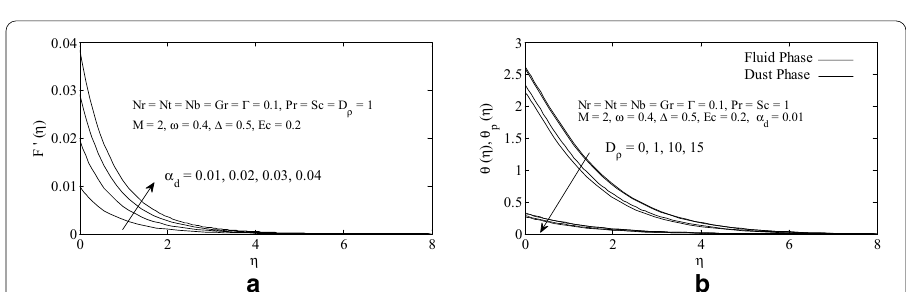
Fig. 5 a , b Impact of α d on velocity profile F ′ (η) and D ρ on temperature profile ( θ(η) , θ p (η) )